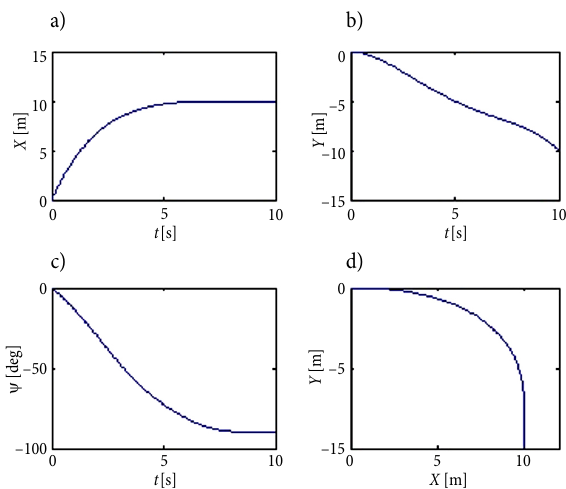
Fig. 5. The planned path for right-angle